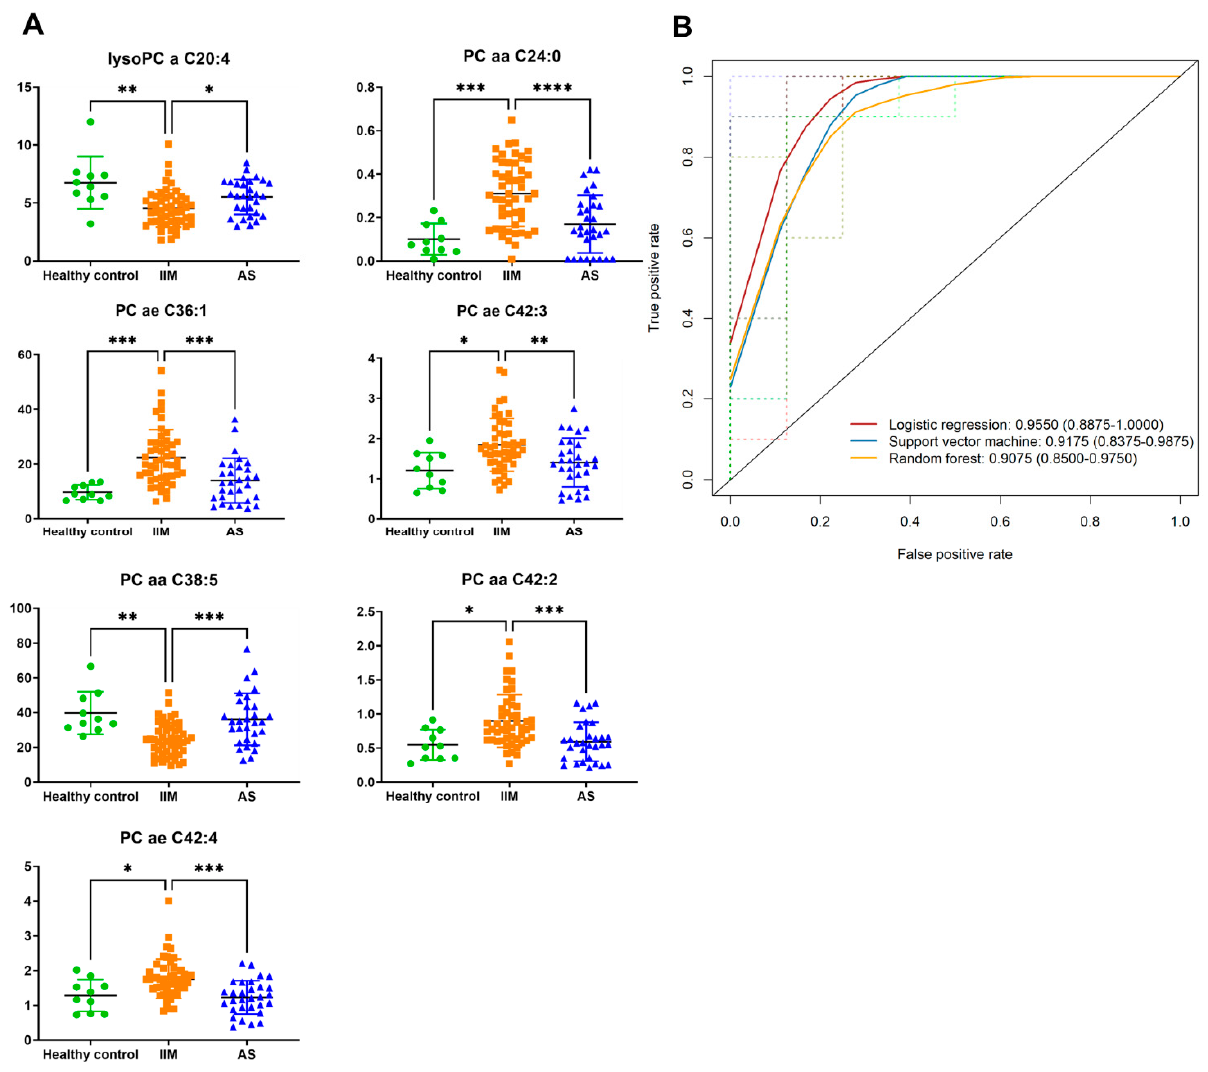
Figure 2. Serum metabolites as biomarkers for IIM. ( A ) The individual plot of IIM-specific metabolites was selected by the backward stepwise method for constructing a prediction model. * p < 0.05; ** p < 0.005; *** p < 0.0005, and **** p < 0.0001. ( B ) ROC curves for seven sets of metabolites with five- fold cross-validation. AUC values were calculated for each machine learning method; red indicates logistic regression, blue indicates support vector machine, and yellow indicates random